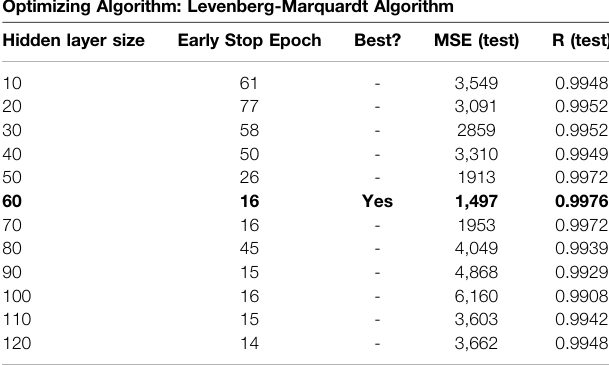
TABLE 4 | MSE loss at various neurons at the hidden layer. Bold values represent the best con fi guration for the model. Model: Arti fi cial neural network Optimizing Algorithm: Levenberg-Marquardt Algorithm Hidden layer size